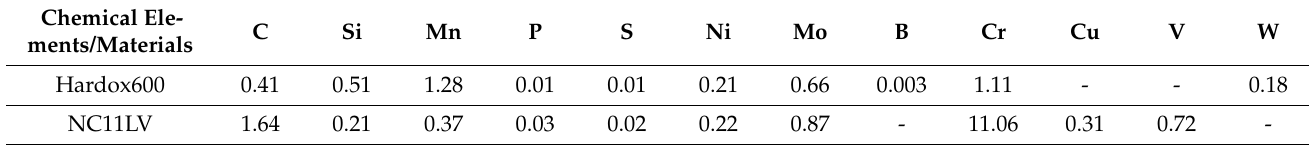
Table 1. Chemical composition of NC11LV and Hardox 600 steels (%).